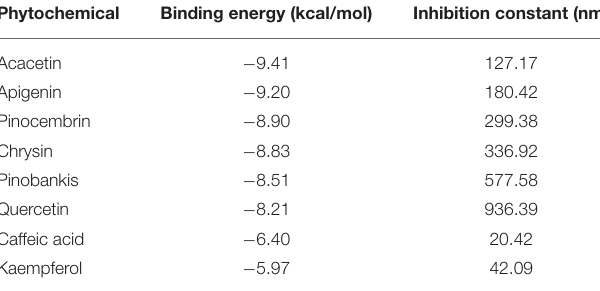
TABLE 4 | E binding values of